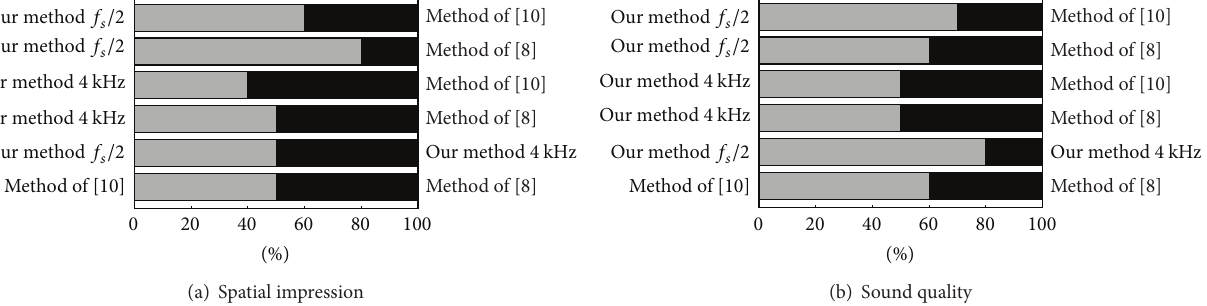
Figure 14: Preference listening test results for the classical music recording with binaural reproduction.